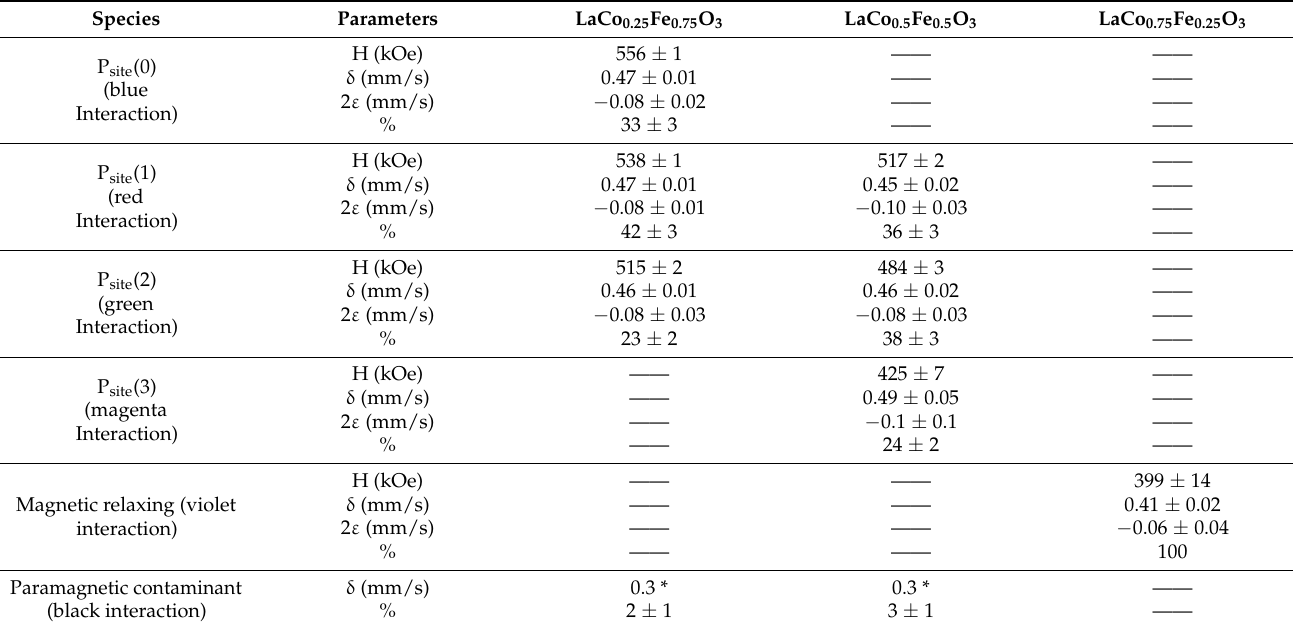
Table 5. Hyperfine Mössbauer parameters of LaFeO 3 , LaCo 0.25 Fe 0.75 O 3 , LaCo 0.5 Fe 0.5 O 3 ,